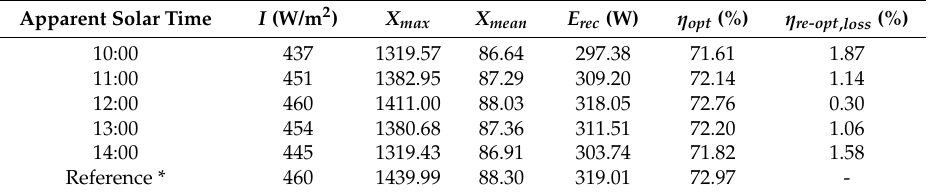
Table 2. Experimental optical characteristics of a fixed-focus Fresnel lens solar concentrator under different apparent solar times measured in this